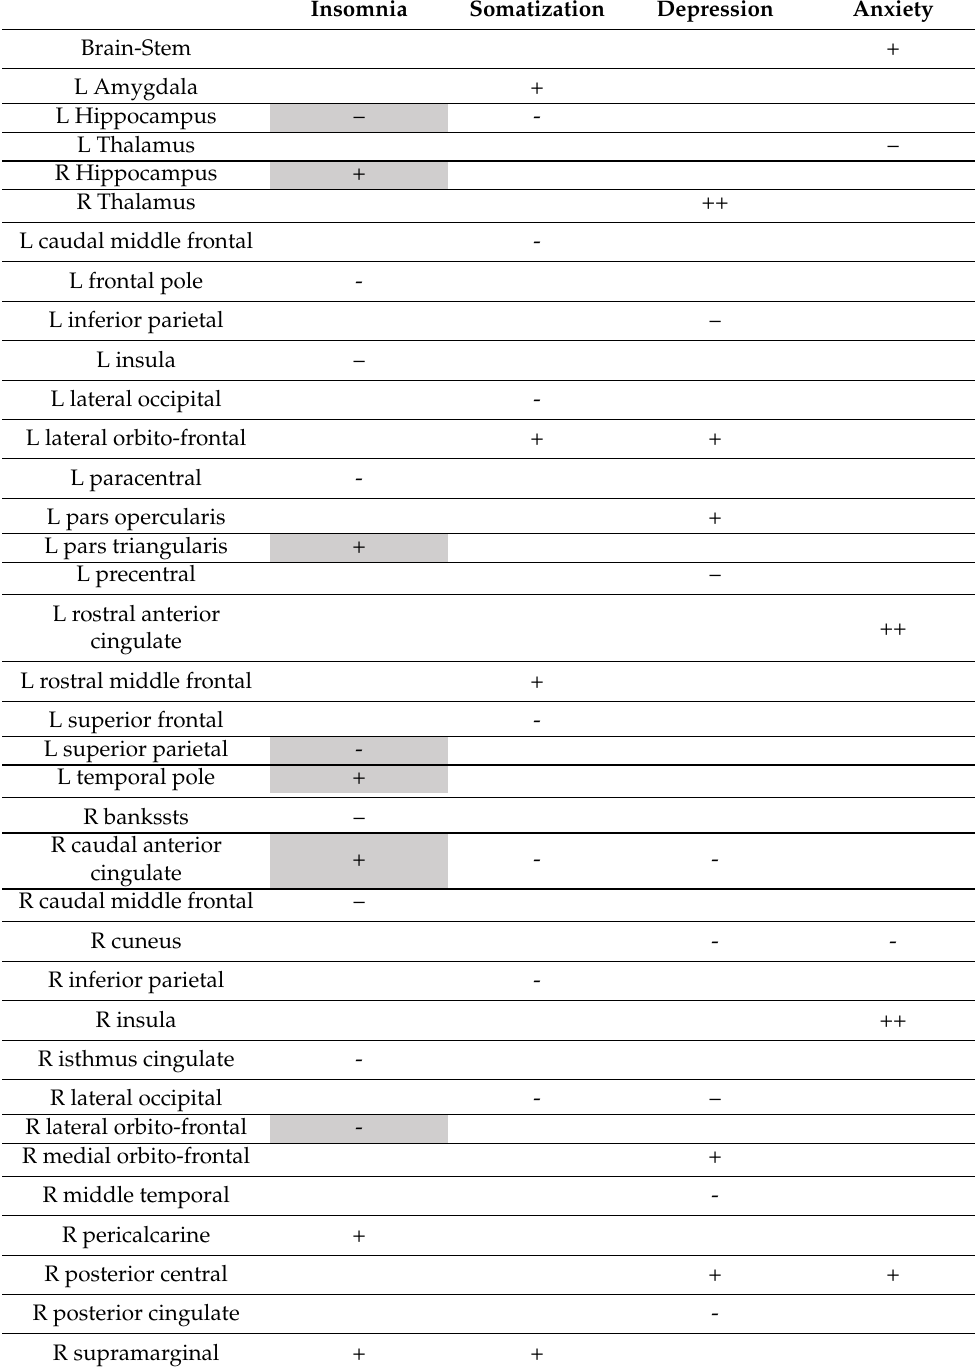
Table 2. The regions whose neuroelectric activity values contributed to the symptom-Scheme 1. are shown. Activity in regions marked “+” was higher in those who screened positive; those marked “-” were lower. Regions marked “++” or “–” made the largest statistical contribution to the classifier. The results for insomnia (2nd step) are highlighted in gray. These were obtained when the regions which were selected for the first classification analysis were excluded. Insomnia Somatization Depression Anxiety